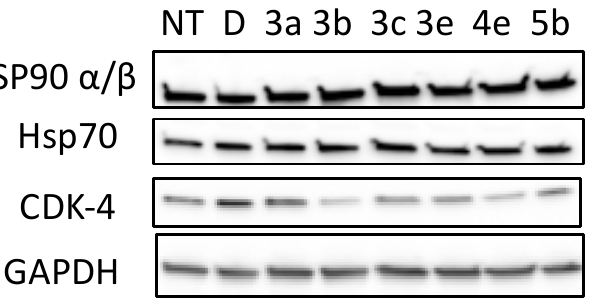
Figure 2. Effects of quinolone analogues 3a–e , 4e and 5b on HSP90 machinery protein levels and on CDK-4 stability. PC-3 cells were grown and exposed to Hsp90 inhibitors ( 3a–e , 4e and 5b , 15 µM) as described in Experimental section for 72 h and cell lysates were analyzed by Western blotting with regard to the levels of CDK-4, Hsp90 α / β and Hsp70. NT corresponds to untreated cells; D, DMSO-treated cells were used as controls, GADPH level is used for control in protein loading on gels.